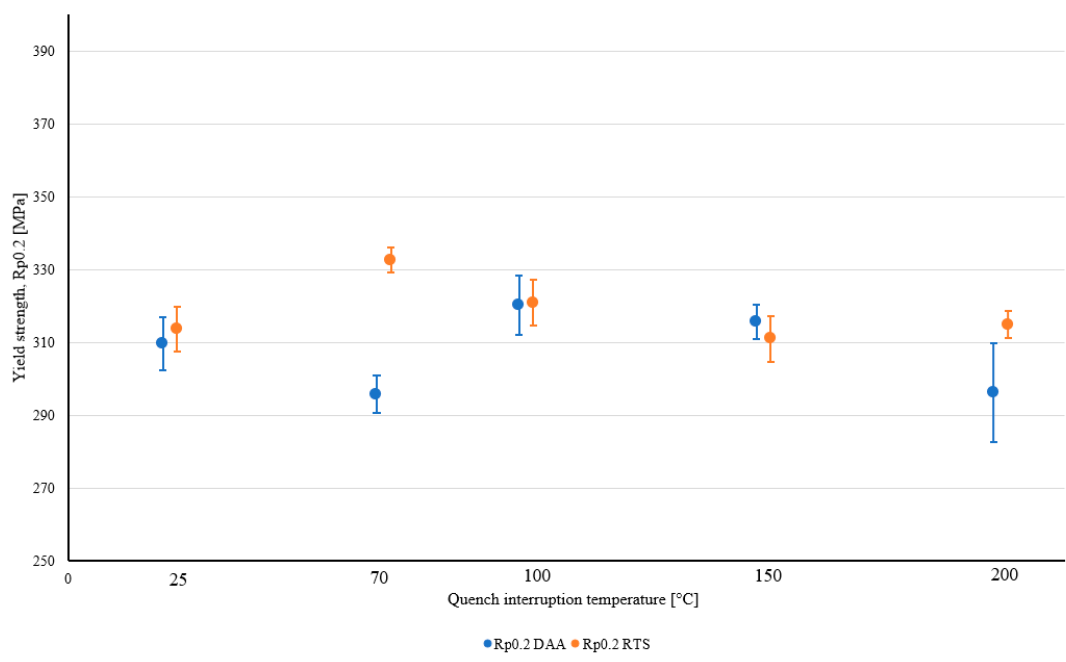
Figure 7. The average yield strength as a function of quench interruption temperature for samples being stored at room temperature or directly artificially aged. Standard deviations are presented by error bars.